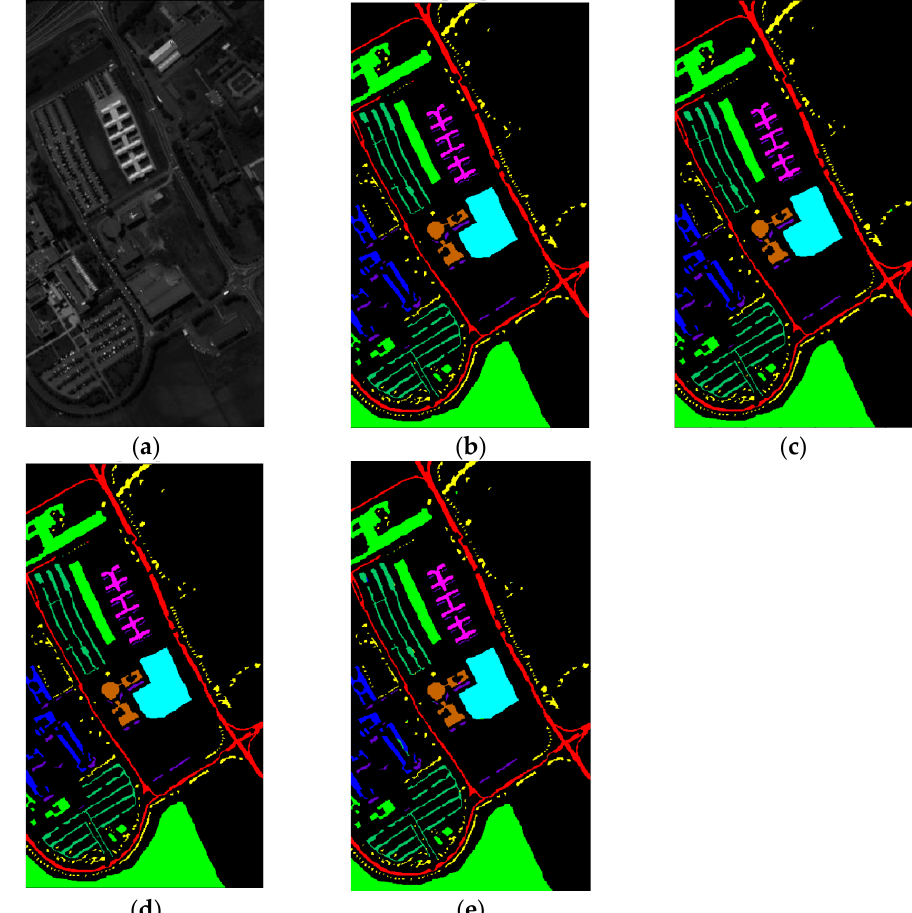
Figure 5. The classification map for the IndianP dataset: ( a ) original image, ( b ) ground truth, and ( c – e ) classification maps obtained using LRCNet, HybridSN, and DSSNet, respectively.